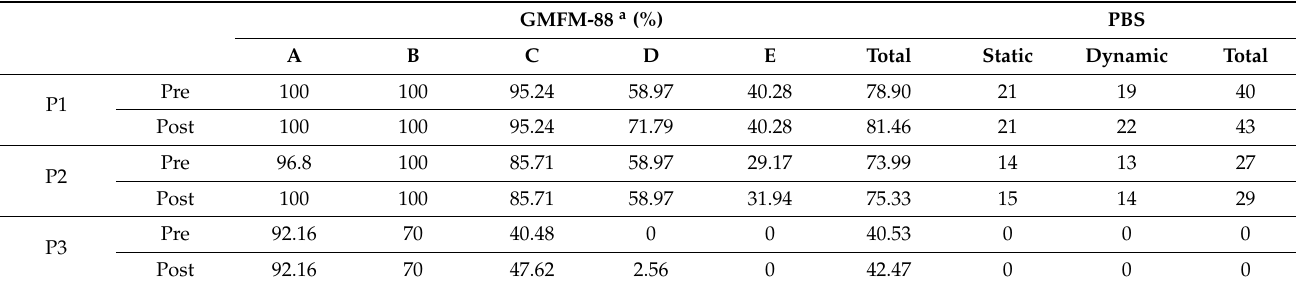
Table 2. Scores of gross motor function measure (GMFM-88) and pediatric balance scale (PBS) in children with cerebral palsy before and after robot-assisted gait